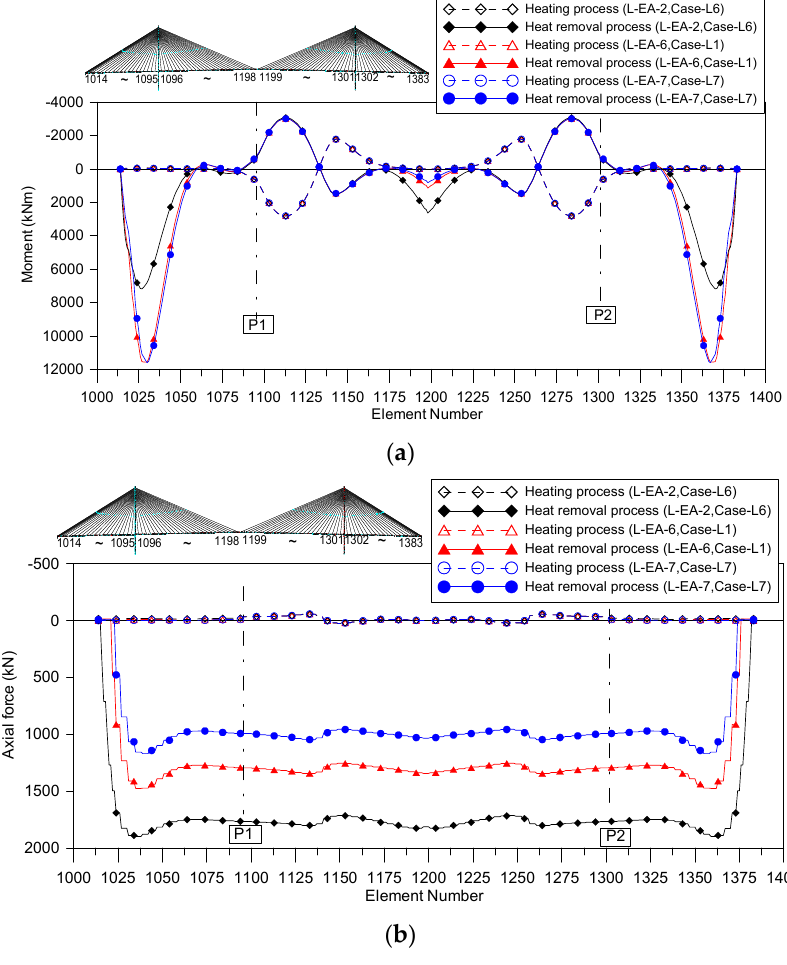
Figure 16. Member forces generated by heating and heat removal with various numbers of earth‐anchored cables. ( a ) Girder bending moments; ( b ) Girder axial forces.